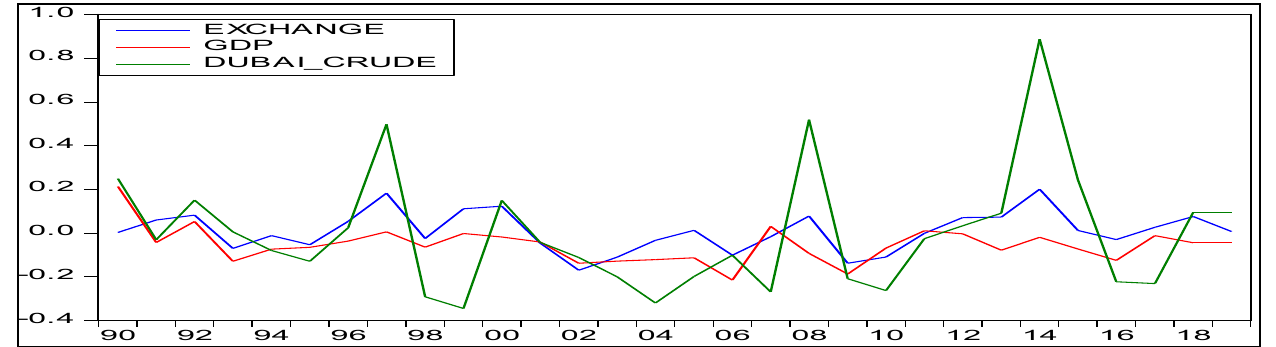
Figure 6. Graphical Expression for the Return Data of Exchange Rates of US dollar (US $)/Indian Rupee (INR), GDP per Capita and Dubai Crude Oil Price in US dollar (US $) during 1990 to 2020;